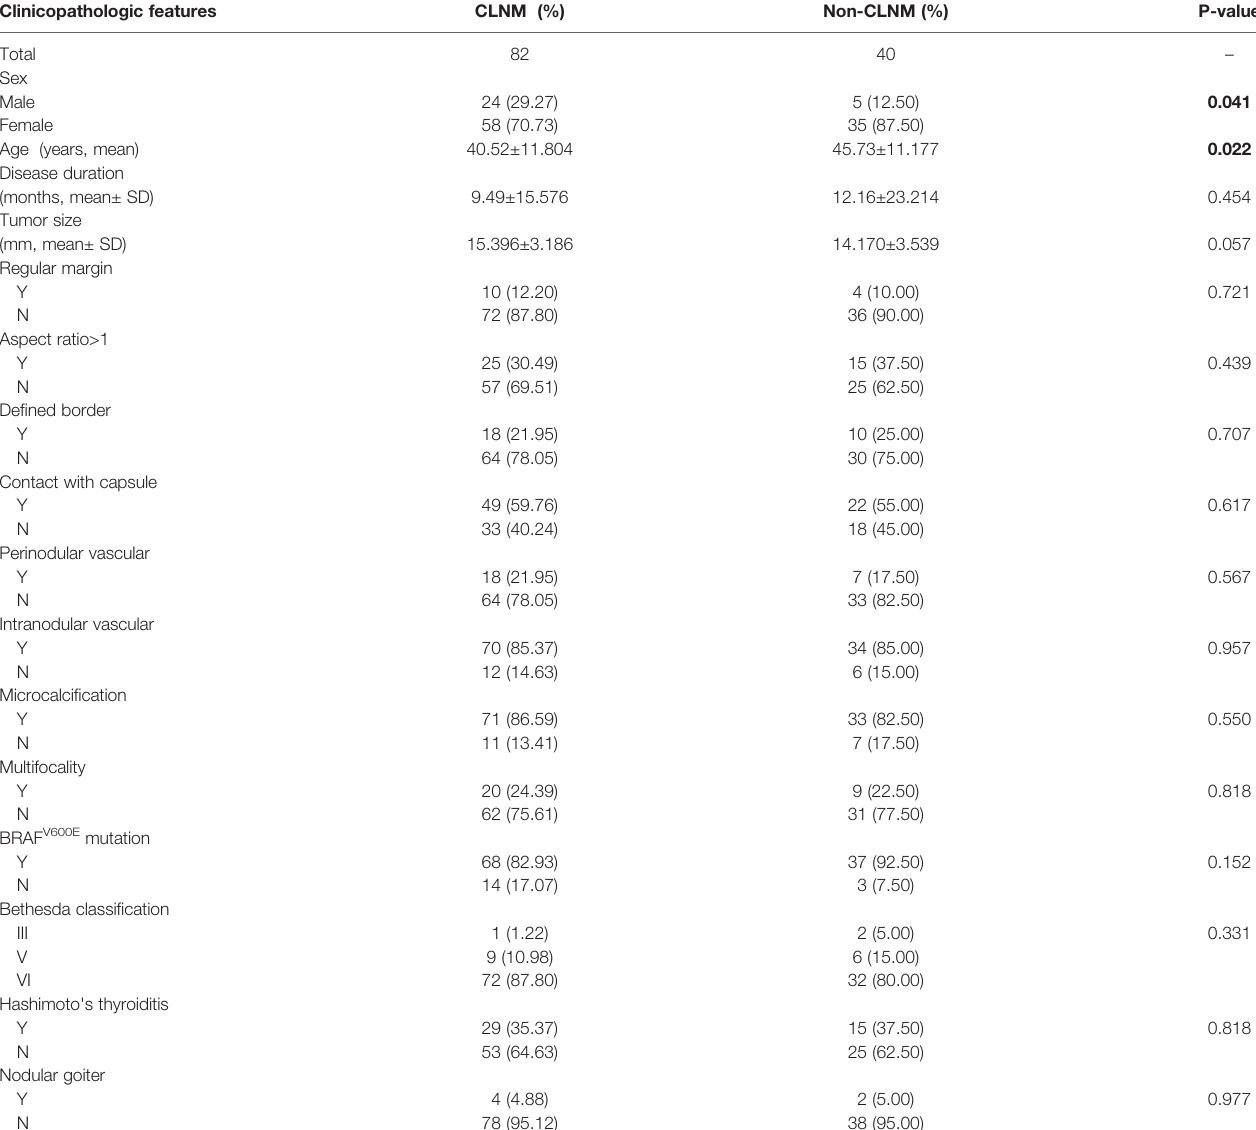
TABLE 4 | Basic clinicopathologic characteristics and US-FNA features PTC (cT1bN0). Clinicopathologic